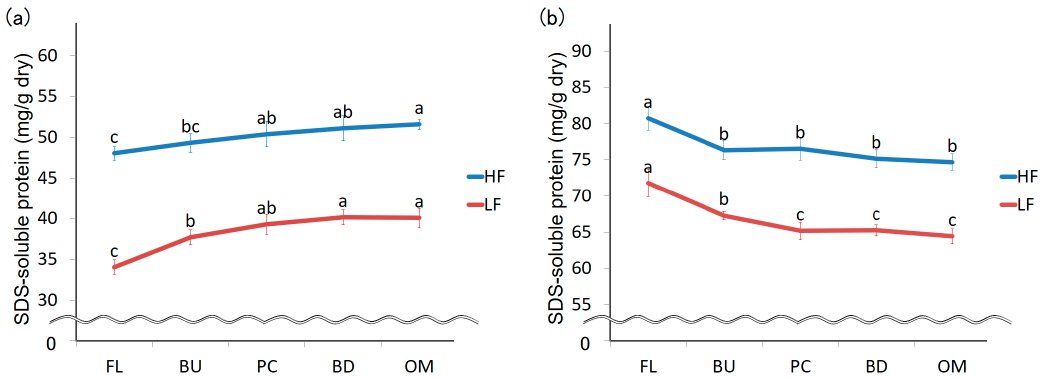
Figure 4. Changes in protein aggregates ( a ) and monomeric protein ( b ) extracted with 0.5% SDS buffer during mixing. FL, BU, PC, BD, and OM indicate flour (before mixing), build up, peak consistency, breakdown and overmixing, respectively. HF and LF mean high protein flour and low protein flour. The error bars show standard deviations ( n = 6). Different letters on the graphs indicate significant differences ( p < 0.05).